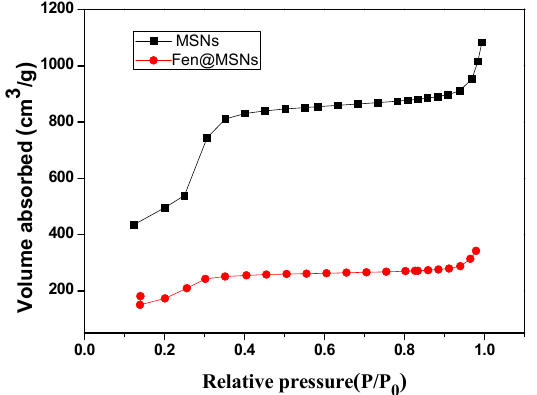
Figure 3. Histogram of the particle size distribution of MSNs.